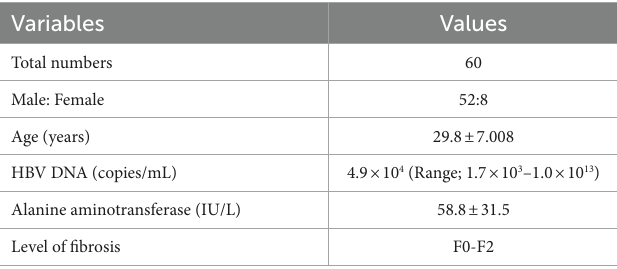
TABLE 1 Data of the 60 patients during enrollment in the phase III trial.